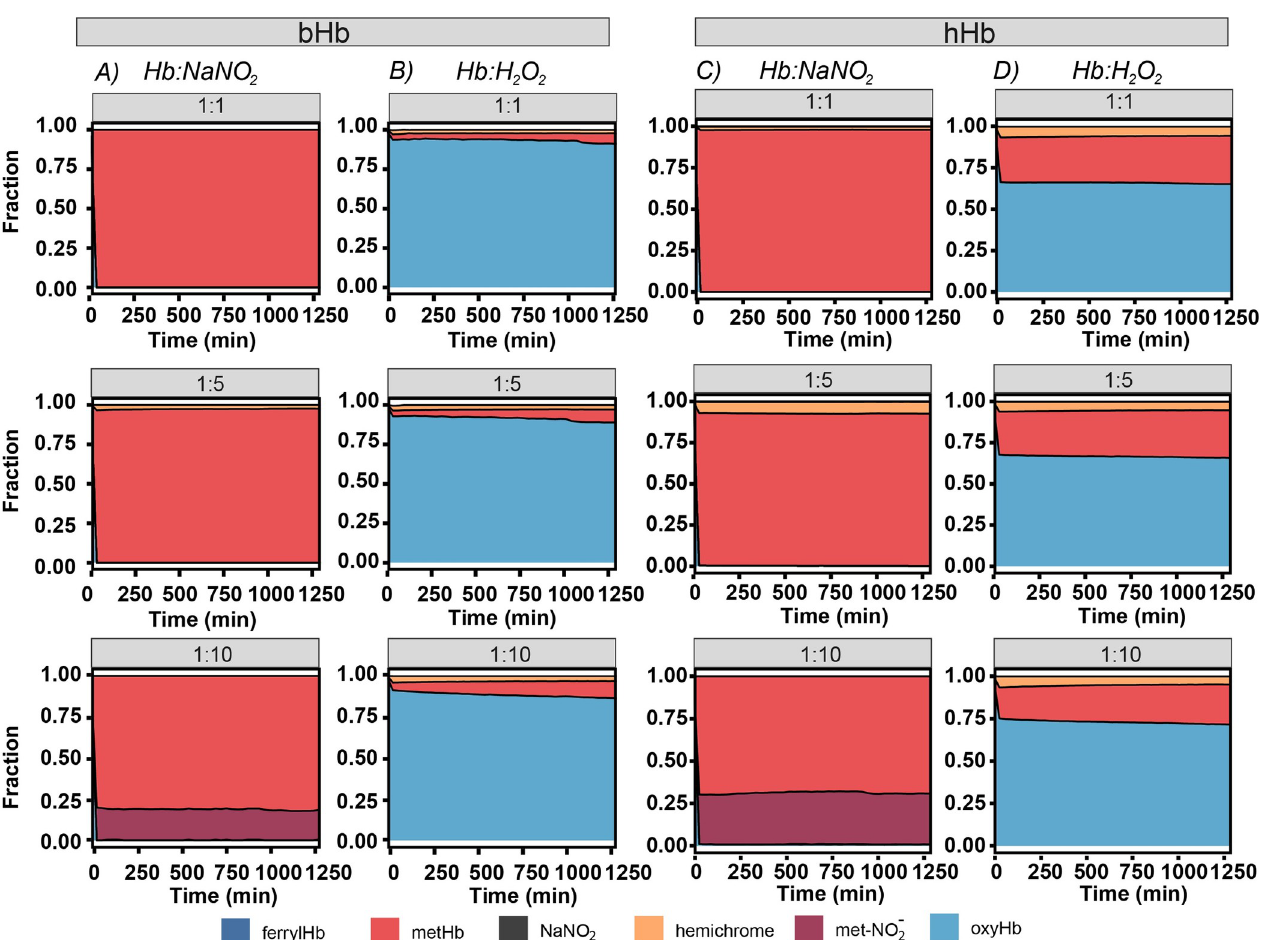
Fig 2. Oxidization of Hb at varying Hb:oxidization agent molar ratio (heme basis, 1:1, 1:5, and 1:10). The oxidation of 60 μ M Hb (heme basis) with either NaNO 2 or H 2 O 2 was monitored via UV-visible spectrometry in 0.1 M PBS pH 7.4 at room temperature for 21 h. Since multiple Hb species were observed, a deconvolution program was used to determine the composition of each Hb species within the reaction mixture at each time point.